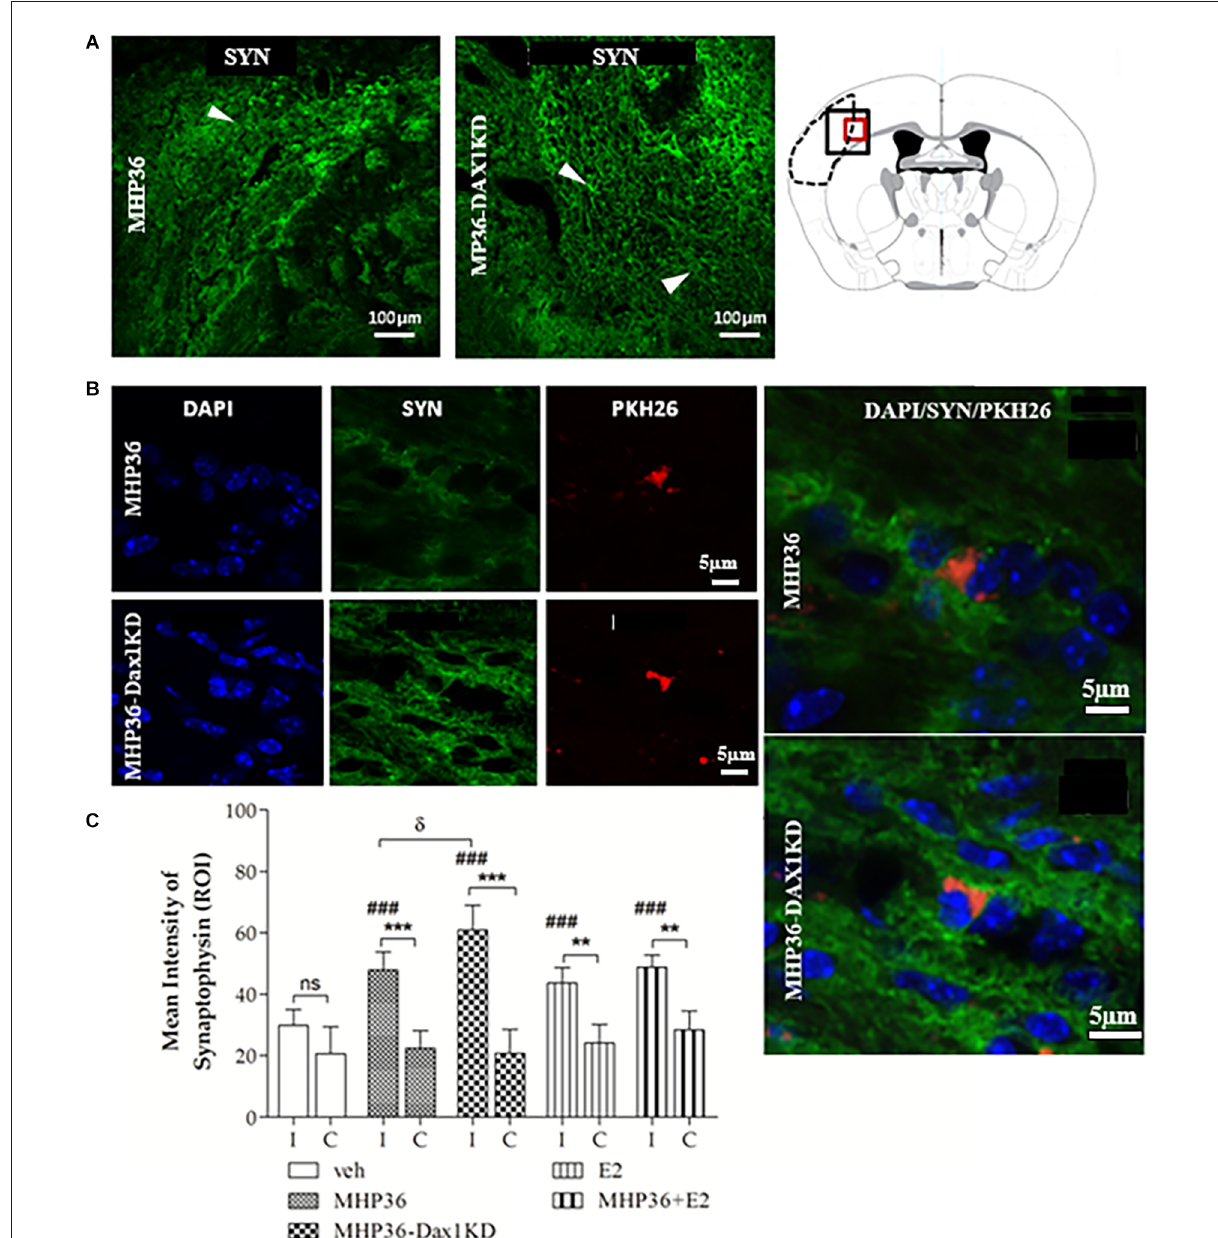
FIGURE5 MHP36-Dax1KD grafts increased expression of synaptophysin in the host brain. (A) Peri-infarct region of interest in the MHP36 and MHP36- Dax1KD injected animals stained with synaptophysin (scale bar = 100 µ m) and schema of the coronal level at Bregma: -0.3 ± 0.10 mm showing region of interest by black box. (B) PKH26-labeled MHP36 and MHP36-Dax1KD co-localized with synaptophysin positive staining at 28 days post MCAO (scale bar = 5 µ m; region of interest is red box in schema of coronal level in A ), with co-localization shown in enlarged images. (C) Graphical representation of mean average intensity of synaptophysin in all experimental groups (** p < 0.01; *** p < 0.001 ipsilateral (I) vs. contralateral (C); ### p < 0.001 vs. vehicle in ipsilateral hemisphere; δ p < 0.05 MHP36 vs. MHP36-Dax1KD); two-way ANOVA, post-hoc Bonferroni’s test to correct for multiple comparisons ( n = 3 all